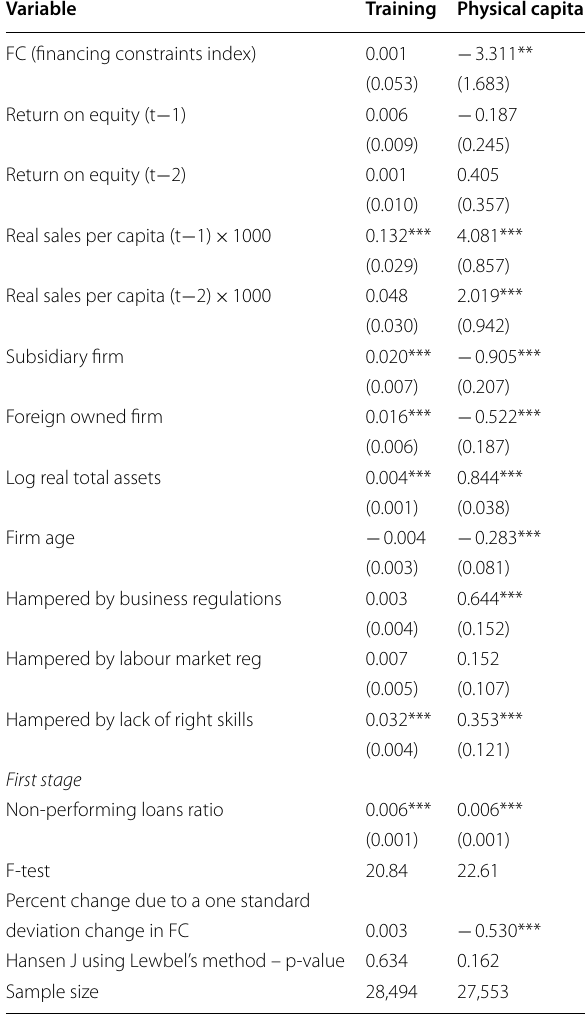
Table 5 The effect of the financing constraints index (FC) on investment in training per employee (TI) and in physical